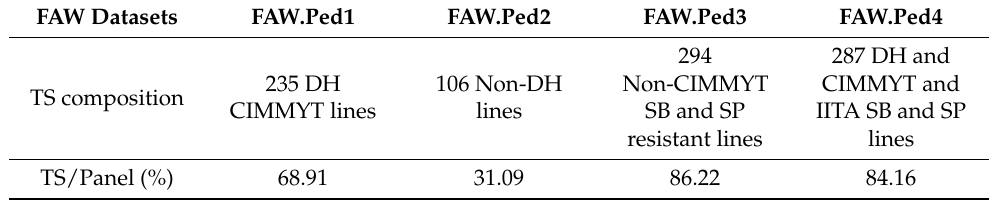
Table 2. Compositions of the pedigree-based test sets (TSs) for fall armyworm (FAW) datasets. FAW Datasets FAW.Ped1 FAW.Ped2 FAW.Ped3 FAW.Ped4 294 287 DH and 235 DH 106 Non-DH Non-CIMMYT CIMMYT and TS composition CIMMYT lines lines SB and SP IITA SB and SP resistant lines lines TS/Panel (%) 68.91 31.09 86.22